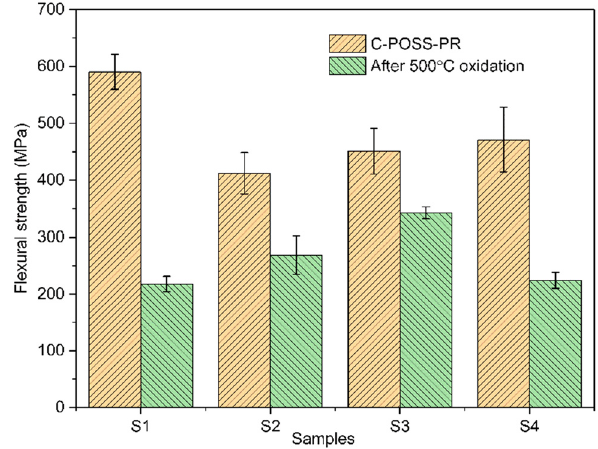
Figure 15: Flexural strength of C - POSS - PR after 500°C oxidation for 10